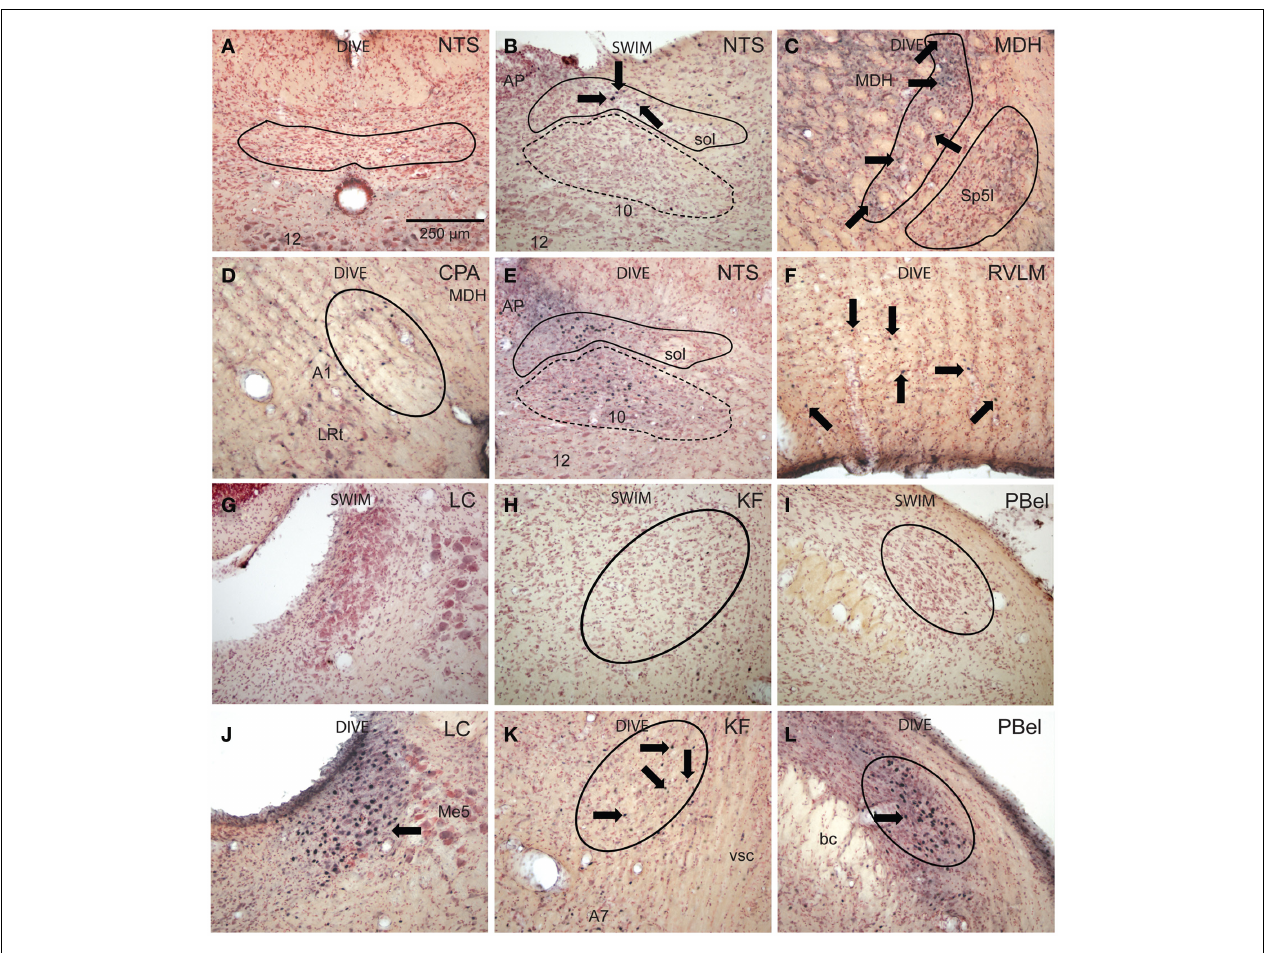
displaced dorsally and medially by the caudal pole of the subnucleus interpolaris (Sp5I, outlined). Neurons labeled with Fos were noted in the caudal pressure area [ (D) CPA, circled] as well as presumptive noradrenergic neurons in the juxtaposed A1 area after diving.There was a significant increase of Fos labeling (arrows) in the RVLM after diving (F) compared to swimming behavior. Little label was seen in the locus coeruleus (G) , Kölliker–Fuse area (H) , or external lateral subnuclei (I) of the parabrachial complex after swimming, but these areas were significantly labeled after diving behavior [ (J,K,L) respectively]. Arrows point to Fos-labeled neurons; all figures at the same